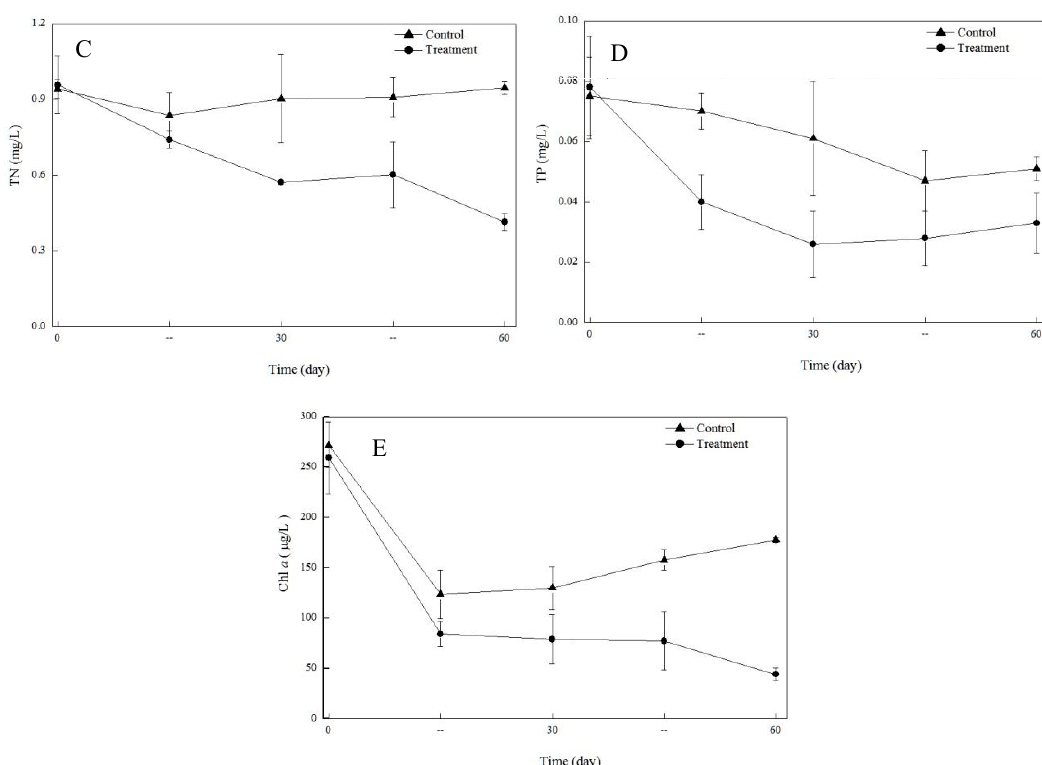
Figure 3. ( A ) turbidity, ( B ) chemical oxygen demand (COD), ( C ) total nitrogen (TN), ( D ) total phosphorous (TP) and ( E ) chlorophyll a (Chl a ) content in the water column over 60 days. Error bars represent the standard deviation (n = 3 × 2).